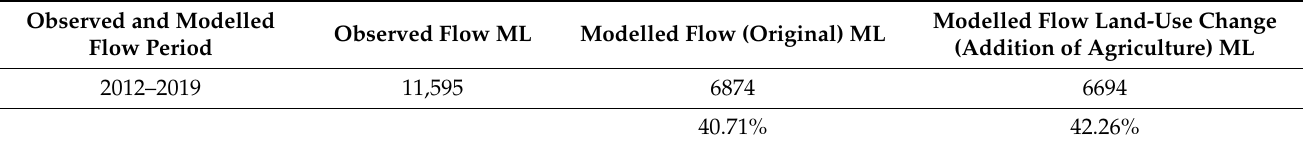
Table 8. Before and after the land-use change water quantity data.